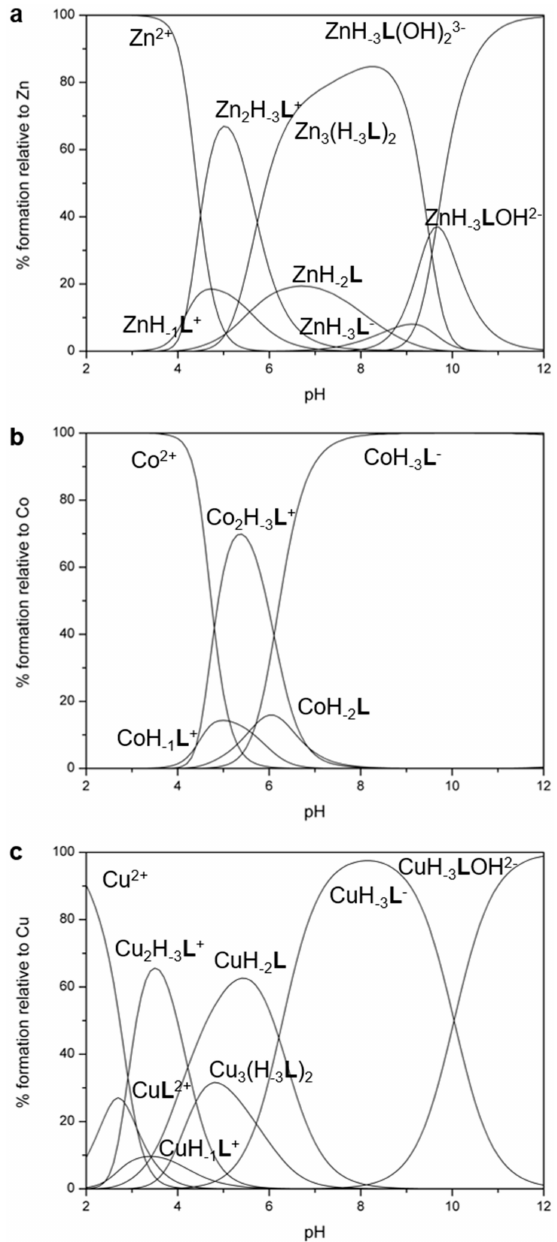
Figure 6. Distribution diagram of the species for the ( a ) L -Zn(II), ( b ) L -Co(II) and ( c ) L -Cu(II) ( L = L2 ) system in 1:1 molar ratio as a function of pH in an aqueous solution (I = 0.15 mol dm − 3 NMe 4 Cl, T = 298.1 K, [ L ] = [Zn(II)] / [Co(II)] / [Cu(II)] = 1 × 10 − 3 mol dm − 3